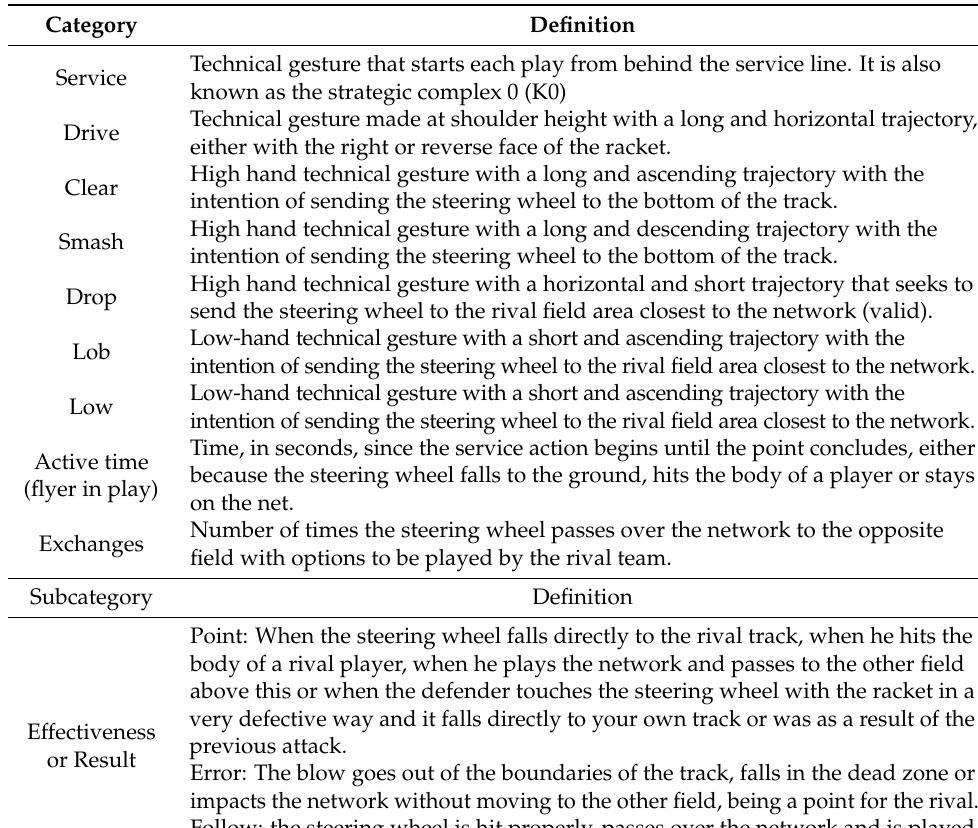
Table 1. Definition of the technical variables analysed (categories and